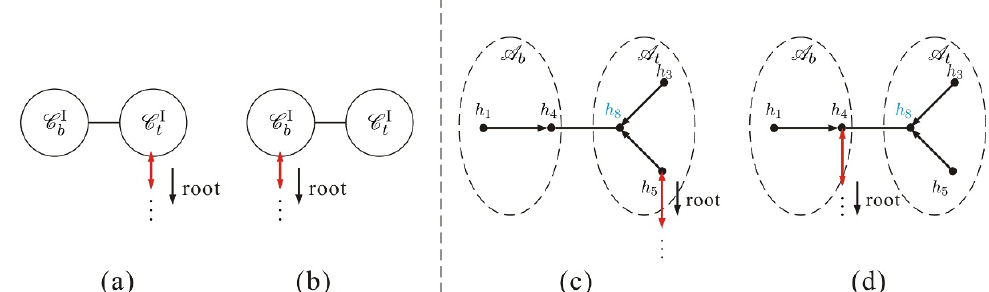
chain must contain the kernel of C I . In other words, the bottom-side end node of the kernel